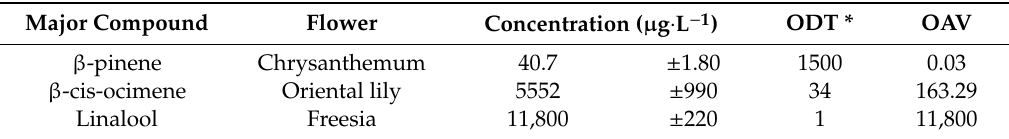
Table 3. The concentration of major compounds detected in the floral scent of chrysanthemum, lilium,